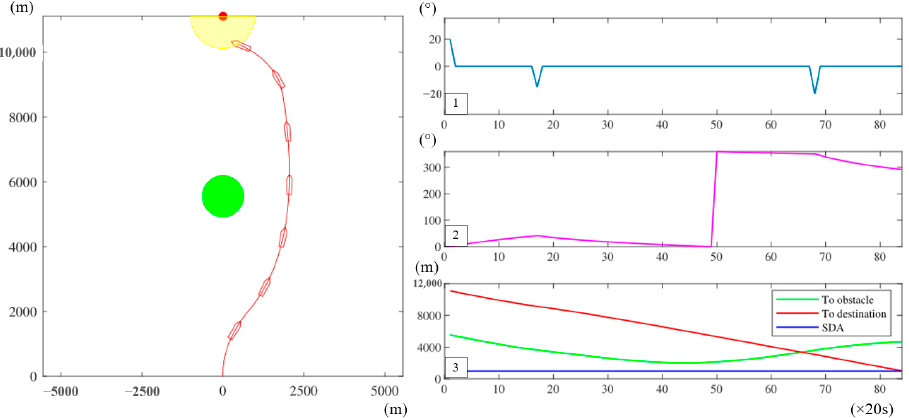
Figure 11. Simulation result for avoiding a single obstacle (1: rudder angle; 2: course; 3: distance).